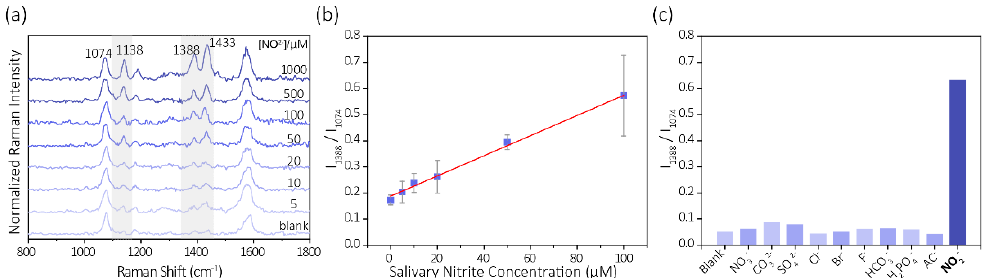
Figure 5. Quantification of nitrite in human saliva. ( a ) SERS spectra of GNP-PATP probe to the saliva sample containing various nitrite. with different concentrations. ( b ) Calibration curves are generated by plotting the normalized intensity of the peaks at 1388/1074 cm − 1 as a nitrite concentration function. ( c ) Normalized intensities of the peaks at 1388/1074 cm − 1 towards competing ions (Competing ions and NO 2 − : 100 µM).